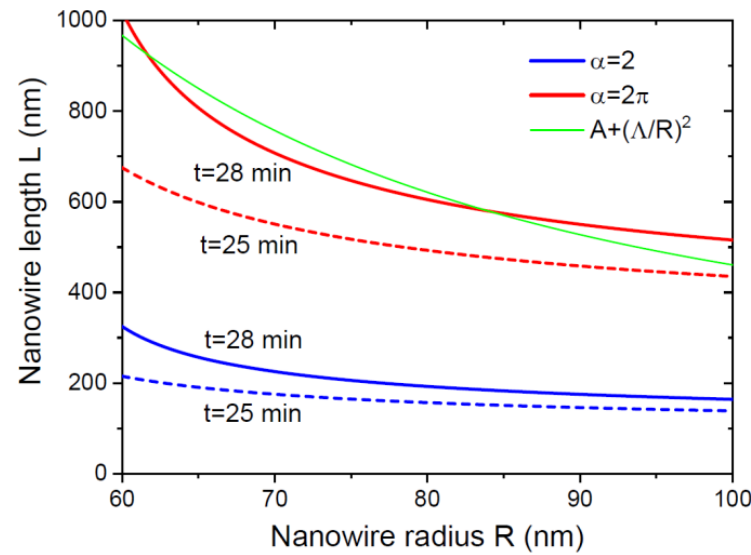
Figure 5. Length–radius correlations of the same NWs as in Figure 4 after different growth times of 25 min (dashed lines) and 28 min (solid lines). A growth time of 28 min corresponds to the end of stage 1 at 𝛼 = 2𝜋 . The green line shows the diffusion-induced curve at a constant radius, given by 𝐿 = [𝐴 + (Λ 𝑅⁄ ) 2 ]𝐻 , with 𝐻 = 352 nm as the equivalent 2D layer thickness after 28 min at 𝛼 = 2𝜋 .